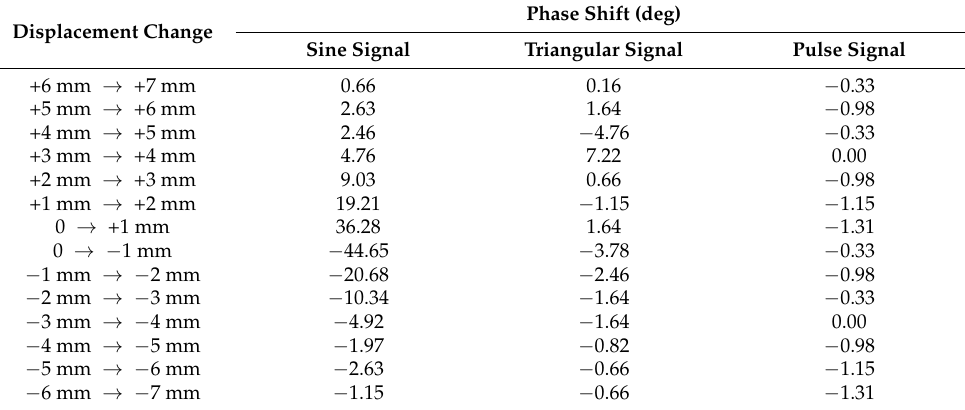
Table 1. Phase shift of three excitation signals.